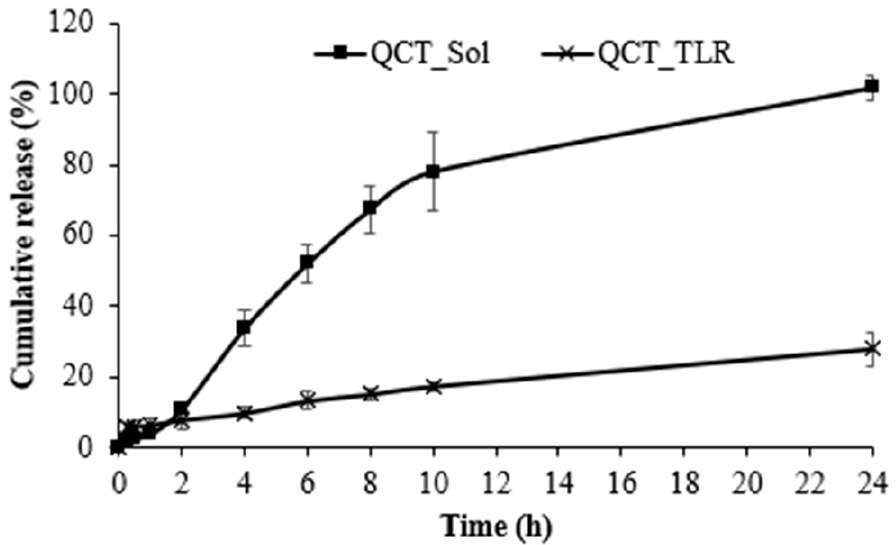
Figure 5. Release profile of QCT solution (QCT_Sol) and QCT_TLR.